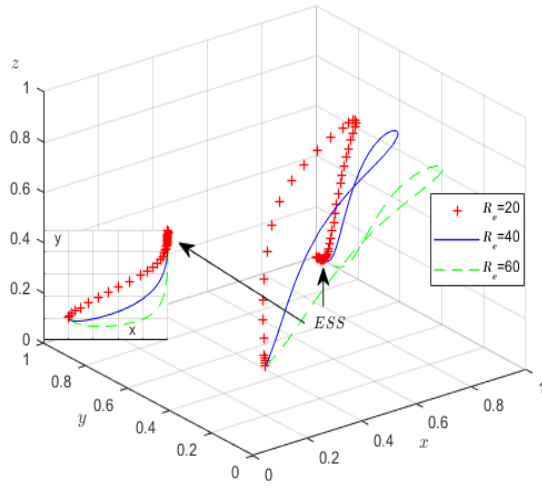
Figure 9. The influence of R e on evolutionary processes.